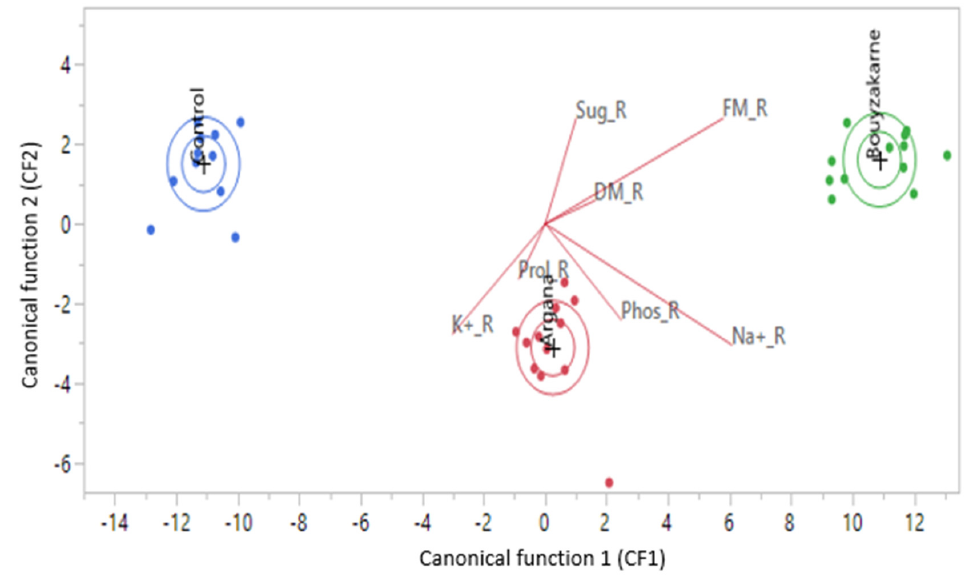
Figure 9. Two-dimensional point cloud showing the separation of the inoculum studied according to the two gradients of the discriminating functions obtained by CDA for the parameters recorded in the root part (FM_R: root fresh matter, DM_R: root dry matter, Sug_R: root sugar, Prol_R: root proline, Phos_R: root phosphorus).